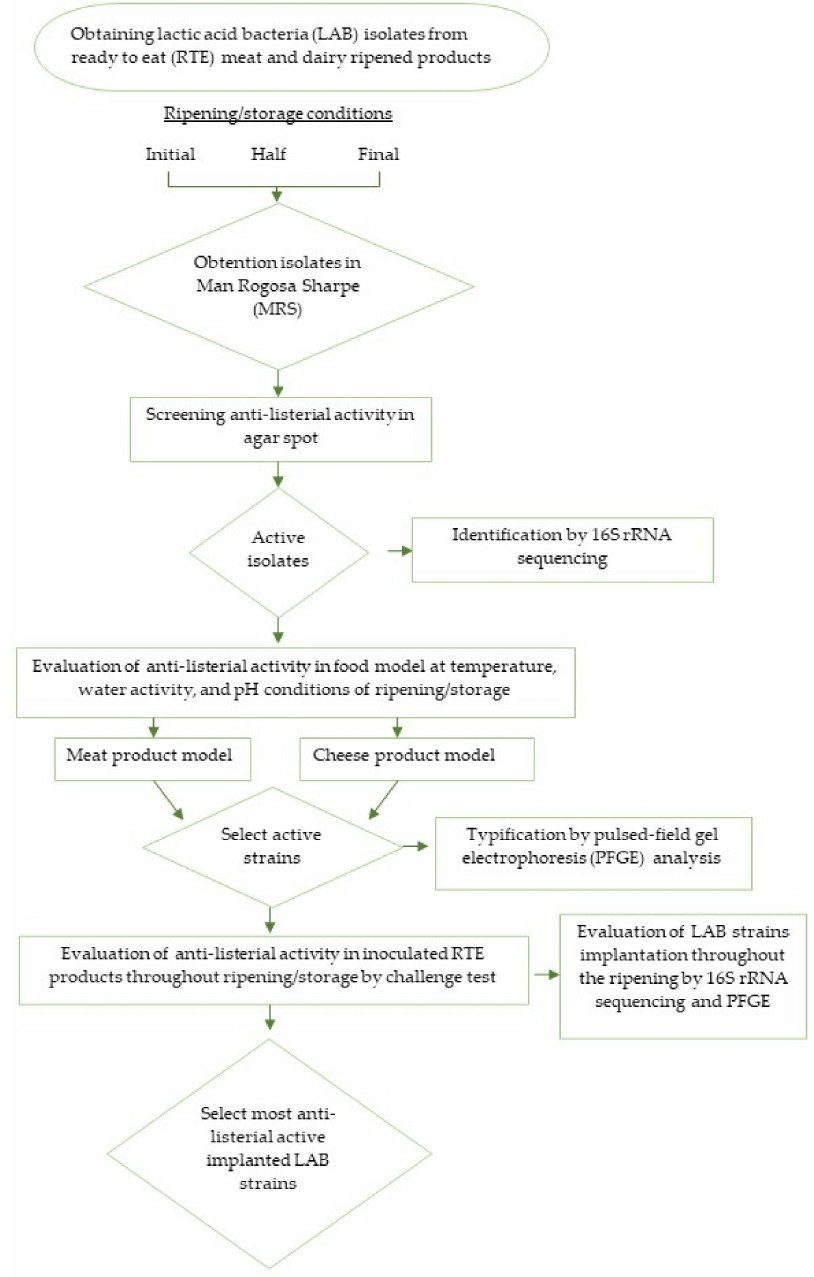
Figure 1. Diagrammatic flowchart for the isolation and selection of LAB strains with anti-listerial activity from RTE meat and dairy